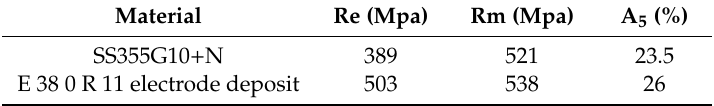
Table 2. Mechanical properties of materials used according to manufacturer